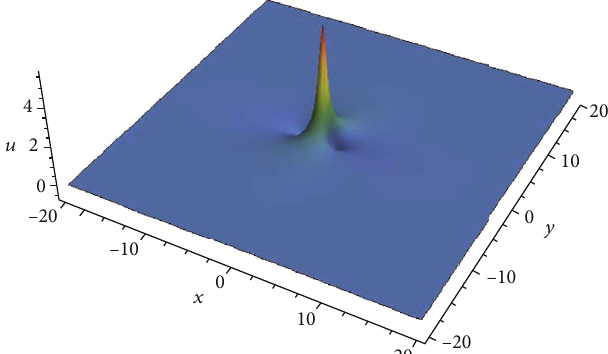
= − 0 : 2 , a = 1 : 2 , and t = 0 . 2 6